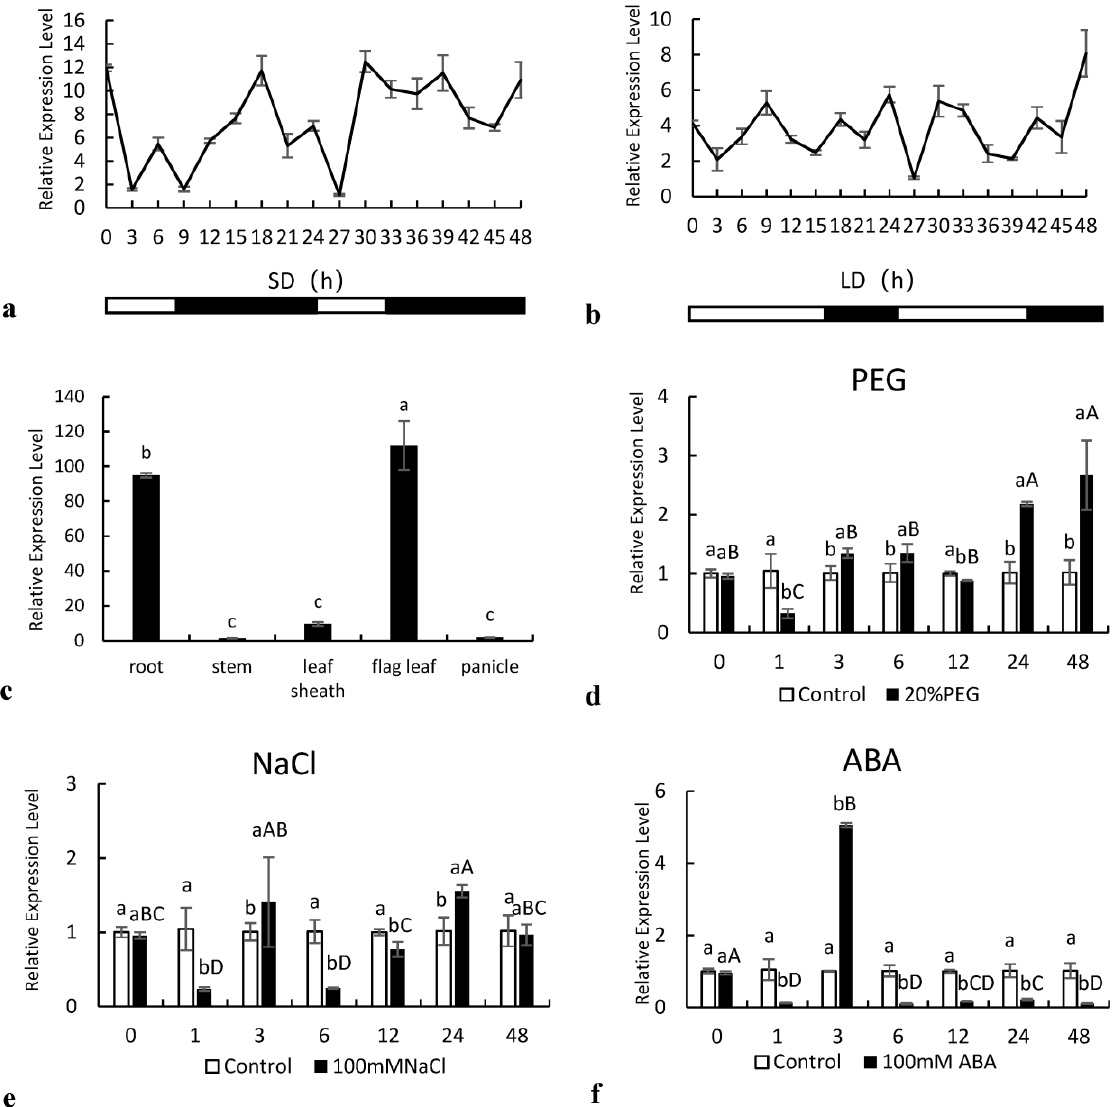
Figure 3. Expression analysis of SiNF-YC2 . ( a ) Short-day (SD) photoperiod. ( b ) Long-day (LD) photoperiod. ( c ) Relative expression of SiNF-YC2 in different tissues of foxtail millet. Expression of SiNF-YC2 under ( d ) 20% PEG6000, ( e ) 200 mM NaCl, and ( f ) 100 μM ABA treatments. Different letters on columns indicate significant differences at the level of 0.05. p < 0.05 indicates significant differences between statistical data, p > 0.05 indicates insignificant differences between statistical data, and p < 0.01 indicates extremely significant differences between statistical data. Different lowercase letters indicate differences between the control and treatment at the same time point; different capital letters indicated differences in SiNF-YC2 expression in millet exposed to stress at different time points.